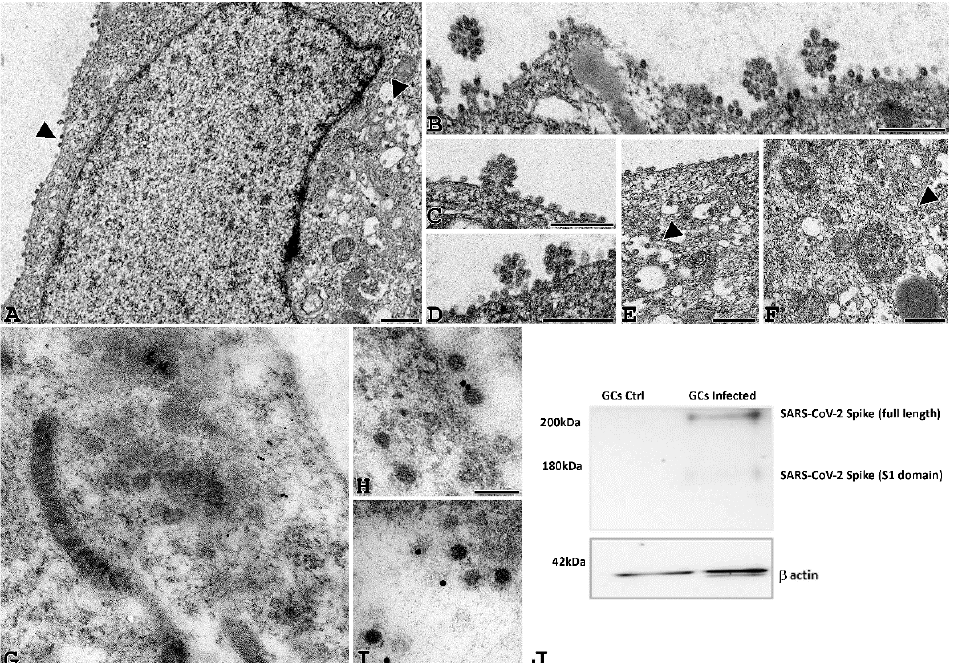
Figure 4. SARS-CoV-2 virions can be detected in GCs infected cells. ( A – F ) Representative electron microscopy images of GCs infected with SARS-CoV2 for 24 h. Viral particles are arranged around the cell membrane ( A – D ) and sometimes grouped in aggregates ( B – D ). Small viral infiltration clusters can be observed within the cytoplasmic compartment ( E – F ), and the ultrastructural organization is not altered (A bar = 1 μ m; B-F, bar 500 nm). ( G – I ) Post-embedding immunogold electron microscopy localization of the spike protein. Localization of spike protein was shown in the cytoplasm of GCs (G, bar = 200 nm); in some cases, gold immunolocalization was observed close to viral particles (H, I, bar = 50 nm). ( J ) Western blot of SARS-CoV-2 spike in human GCs uninfected (GCs Ctrl) or infected with SARS-CoV-2 (GCs infected) for 24 h. The image shows a band of about 170 kD supporting the proteolytic activation of spike associated with viral entry. Equal protein loading of the two preparations was verified using the housekeeping beta-actin. Western blot was repeated twice on a pool of 3